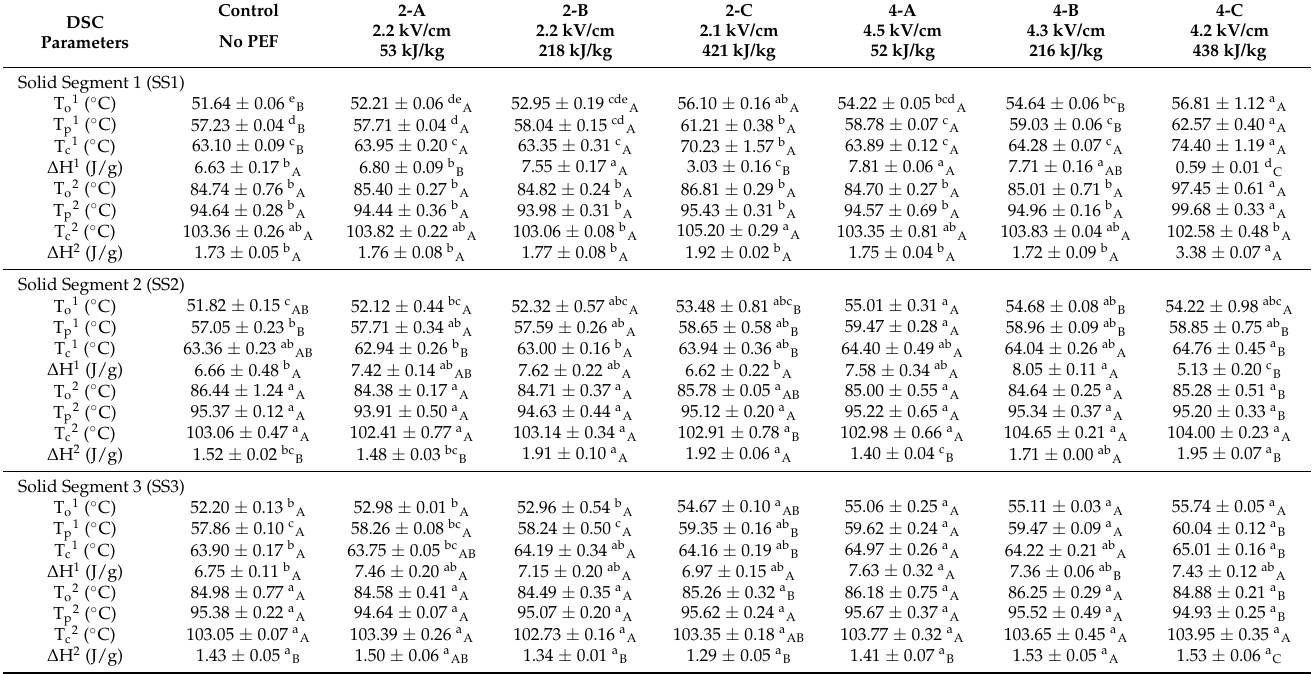
Table 4. Thermal properties of three separate flour segments that were collected after PEF treatment of oat